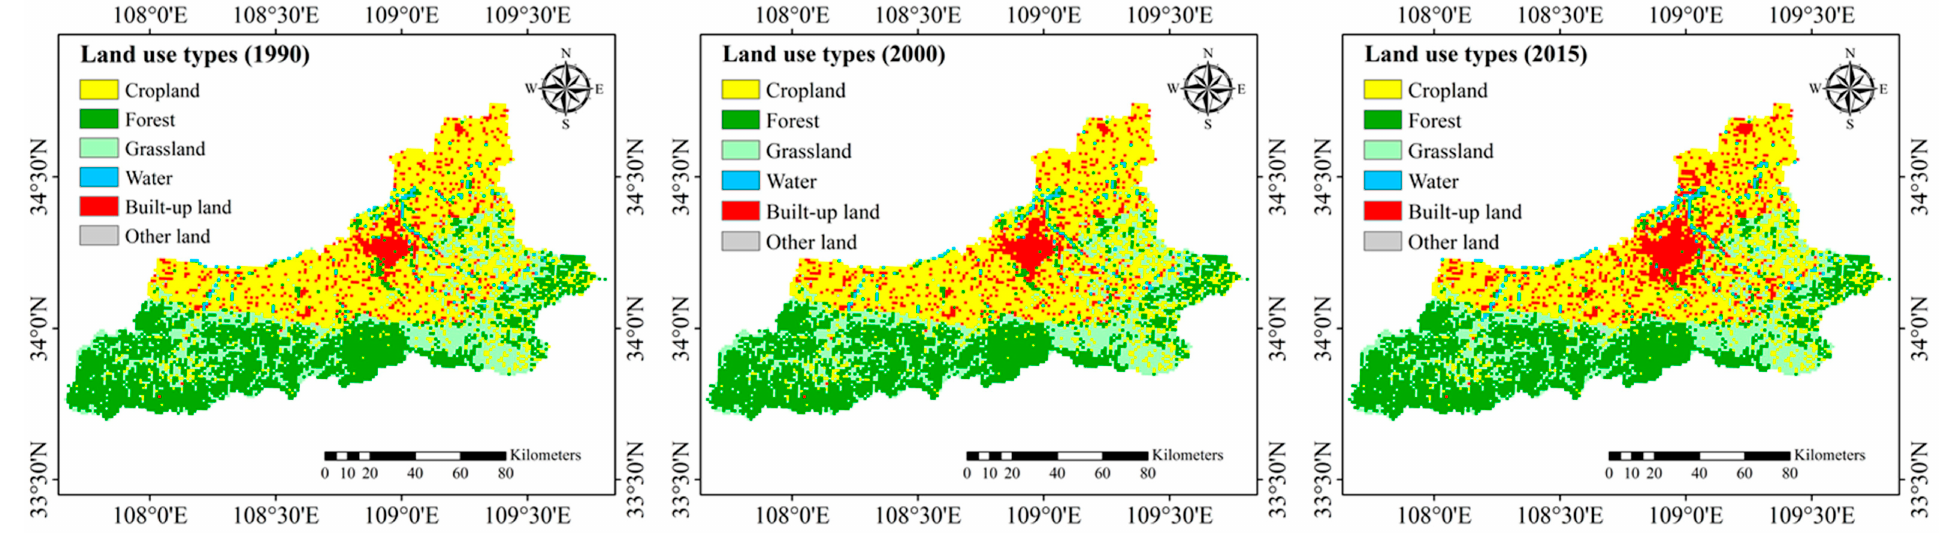
Figure 4. Distribution of the land use in ( a ) 1990, ( b ) 2000, and ( c ) 2015.